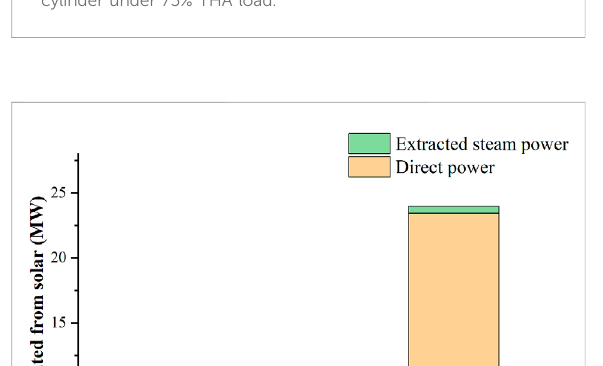
FIGURE 9 Distribution of power generated from solar in the turbine cylinder under 75% THA load.